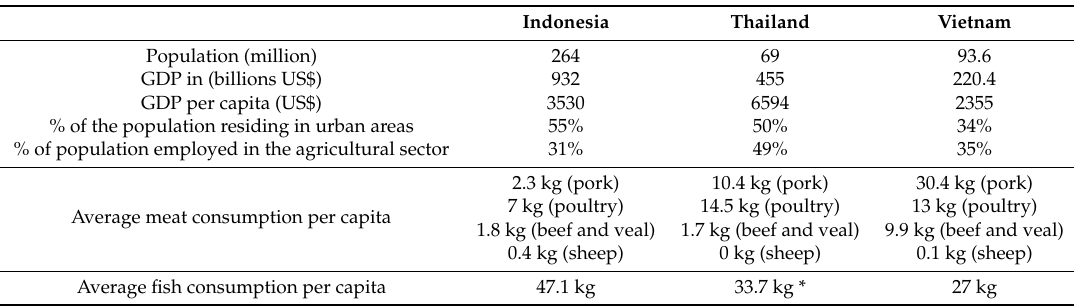
Table 1. Key statistics on the economic status and agricultural sectors in Indonesia, Thailand, and Vietnam in